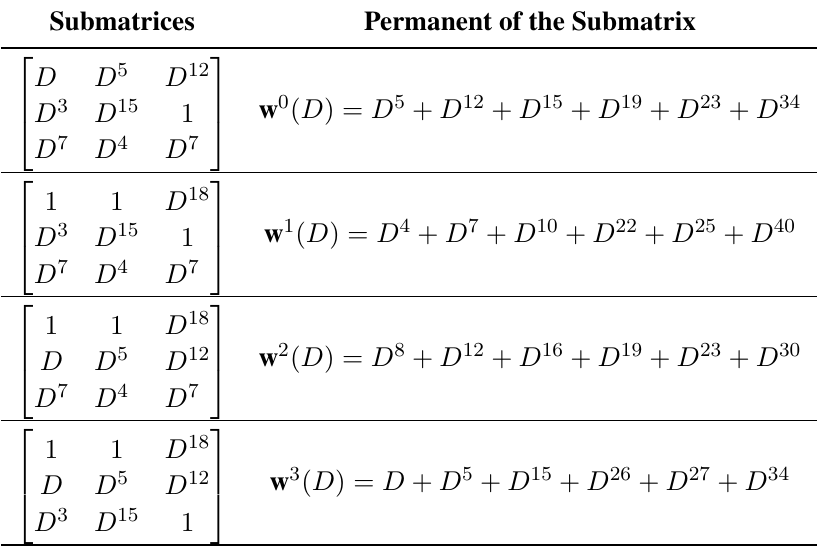
Table 1. The permanent of each square submatrix of Equation (9).